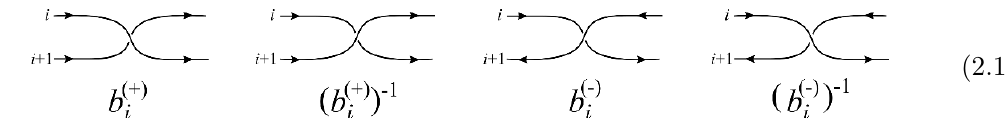
Figure 5 . The state as